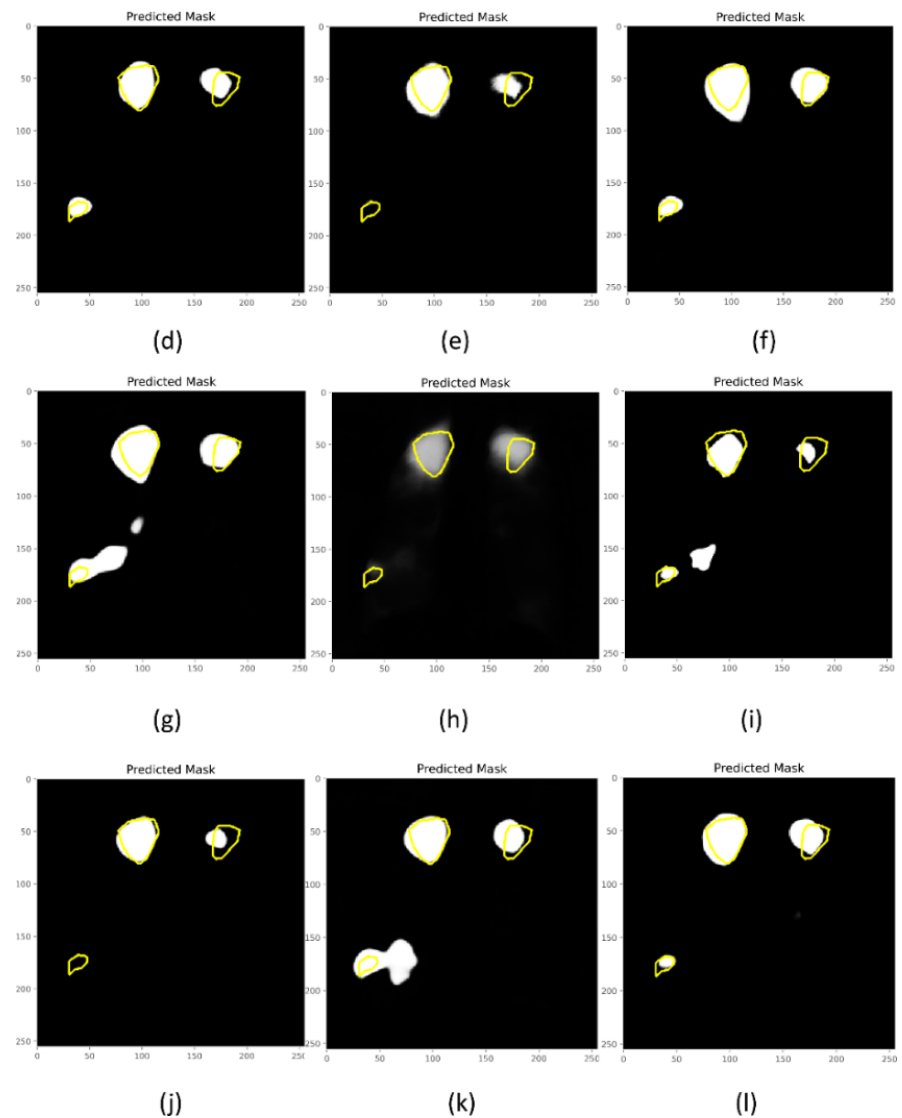
Figure 4. Predictions of the VGG-16-based U-Net model for a sample CXR. ( a ) Input CXR; ( b ) GT mask; Losses without BU ( c ) CE; ( d ) Dice; ( e ) IOU; ( f ) Tversky; ( g ) Focal Tversky; losses with BU ( h ) CE; ( i ) Dice; ( j ) IOU; ( k ) Tversky, and ( l ) Focal Tversky. The pixels in yellow denote the contour of the GT masks.